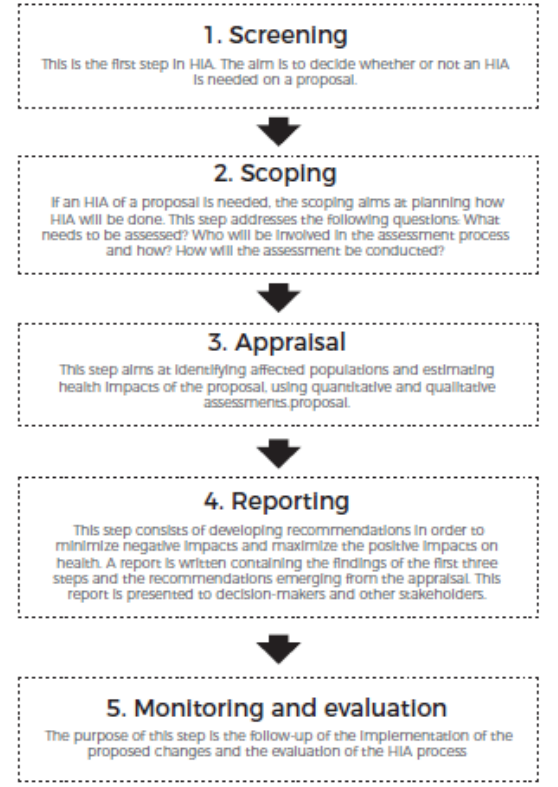
Figure 1. The five steps of the health impact assessment procedure.